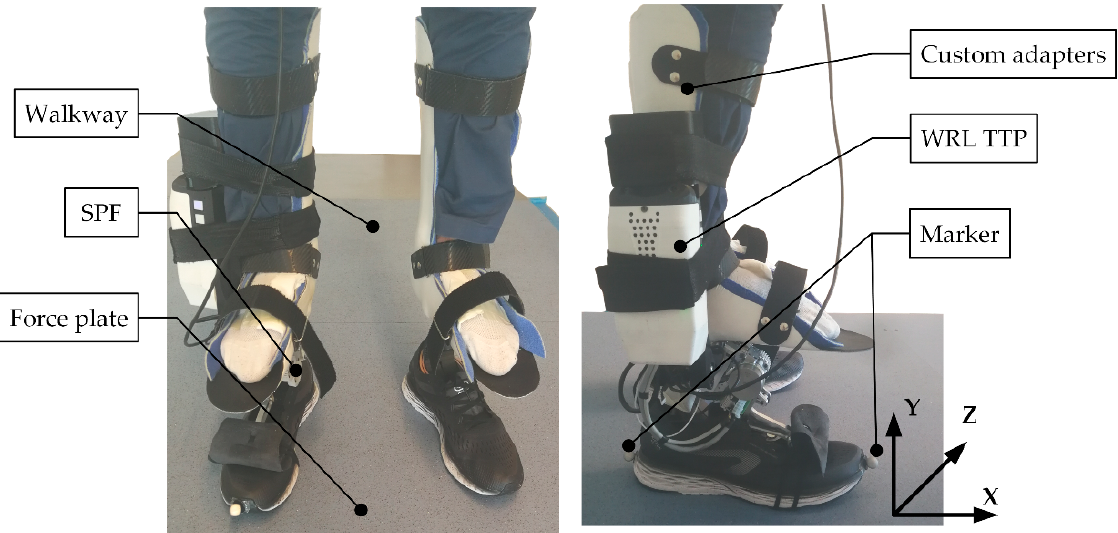
Figure 6. A healthy subject wearing the experimental setup above four force plates: on the right foot, a custom adapter is connected to the WRL TTP and the SPF; on the left foot, the custom adapter is connected to an ESAR foot.